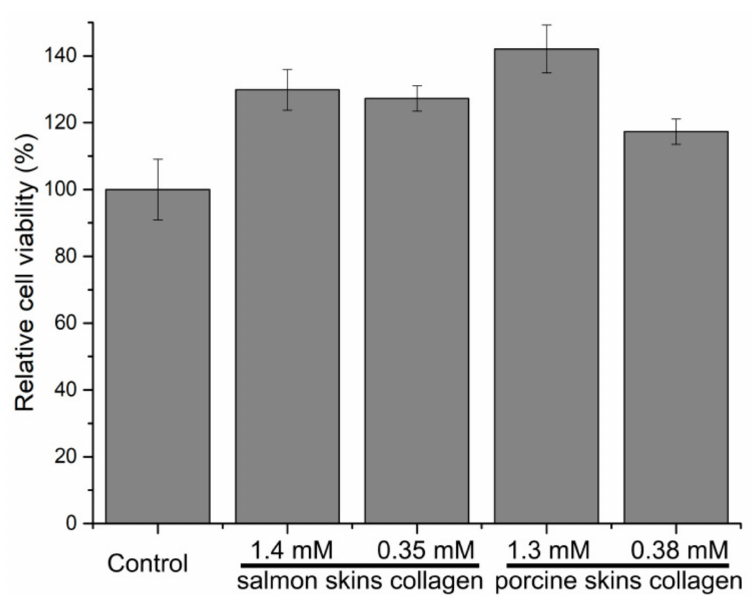
Figure 9. Cell viability as determined by the methylthiazolyldiphenyl-tetrazolium bromide (MTT) assay. Values are expressed as the mean ± SD ( n =